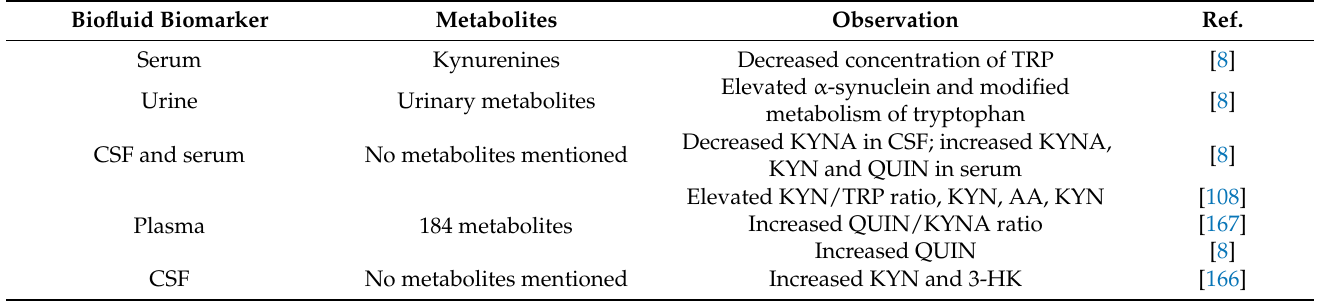
Table 1. Representation of studies of biomarkers in bio-fluids and their effects on KP metabolites in PD. Biofluid